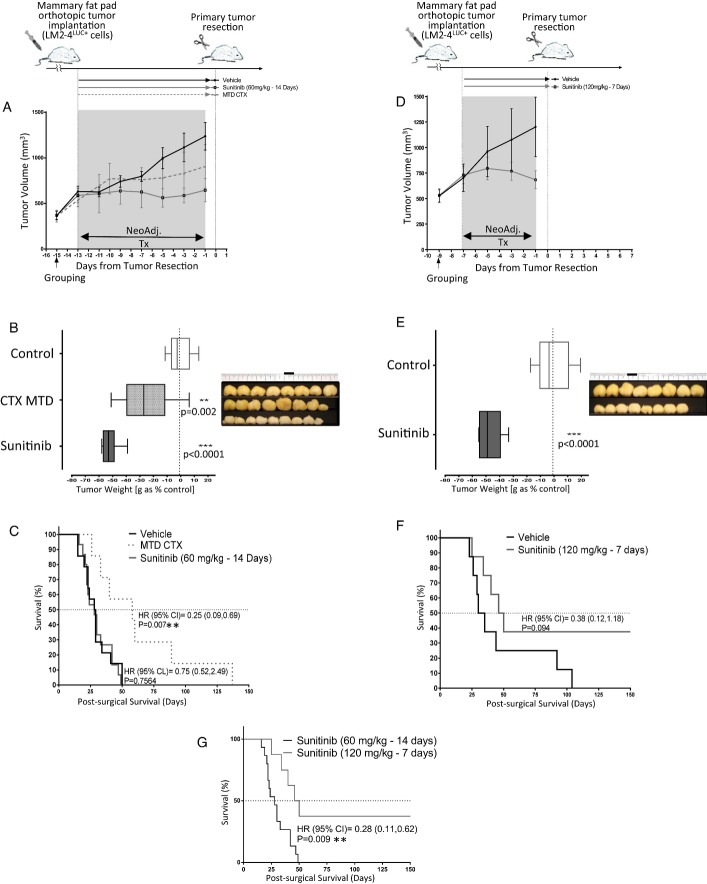
Modulating neoadjuvant sunitinib dose and surgical timing can improve post-surgical
survivalA–CSCID mice implanted with LM2-4LUC+ human breast cancer cells in the
mammary fat pad and treated with three neoadjuvant regimens: vehicle, sunitinib
(60 mg/kg/day), or CTX MTD (100 mg, 3 times weekly) for 14 days. (A) Comparison
of tumor volume by caliper measurement, and (B) comparison of tumor weight following surgery
(36 days post-implantation), with images of excised tumors shown (side panel). (C)
Post-surgical survival following neoadjuvant CTX MTD or sunitinib treatment.D–GSCID mice implanted with LM2-4LUC+ human breast cancer cells in the
mammary fat pad and treated with vehicle or sunitinib (120 mg/kg/day) for 7 days. (D)
Comparison of tumor volume by caliper measurement, and (E) comparison of tumor weight following
surgery (30 days post-implantation), with images of excised tumors shown (side panel). (F)
Post-surgical survival following short-term (high-dose) sunitinib treatment compared to control. (G)
Post-surgical survival comparison of short-term sunitinib treatment at either high (120 mg/kg/day)
or lower (60 mg/kg/day) doses.Data information: Symbols and bars for box and whiskers plot: median (line), upper/lower
quartile (box), min/max (error bars). Survival analysis: hazard ratio (HR), confidence interval
(CI), overall survival (OS) based on Kaplan–Meier or Cox regression analysis.
N = 8–15 mice per group. Neoadj. Tx, neoadjuvant
treatment; **P < 0.01,
***P < 0.001 compared to control.